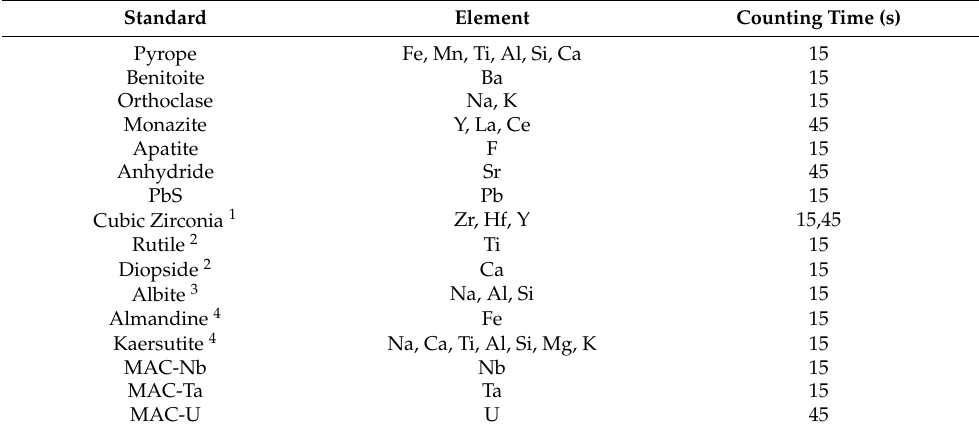
Table A1. Standards used for electron microprobe analyses (the standard used for a given element was employed for all minerals analyzed unless otherwise